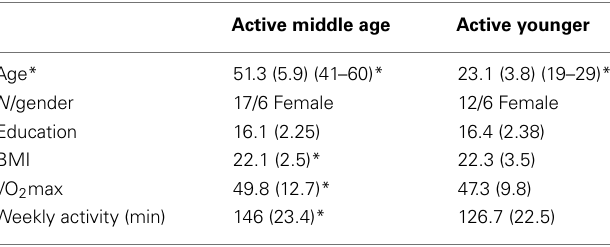
Table 2 |Aerobically fit participant characteristics.